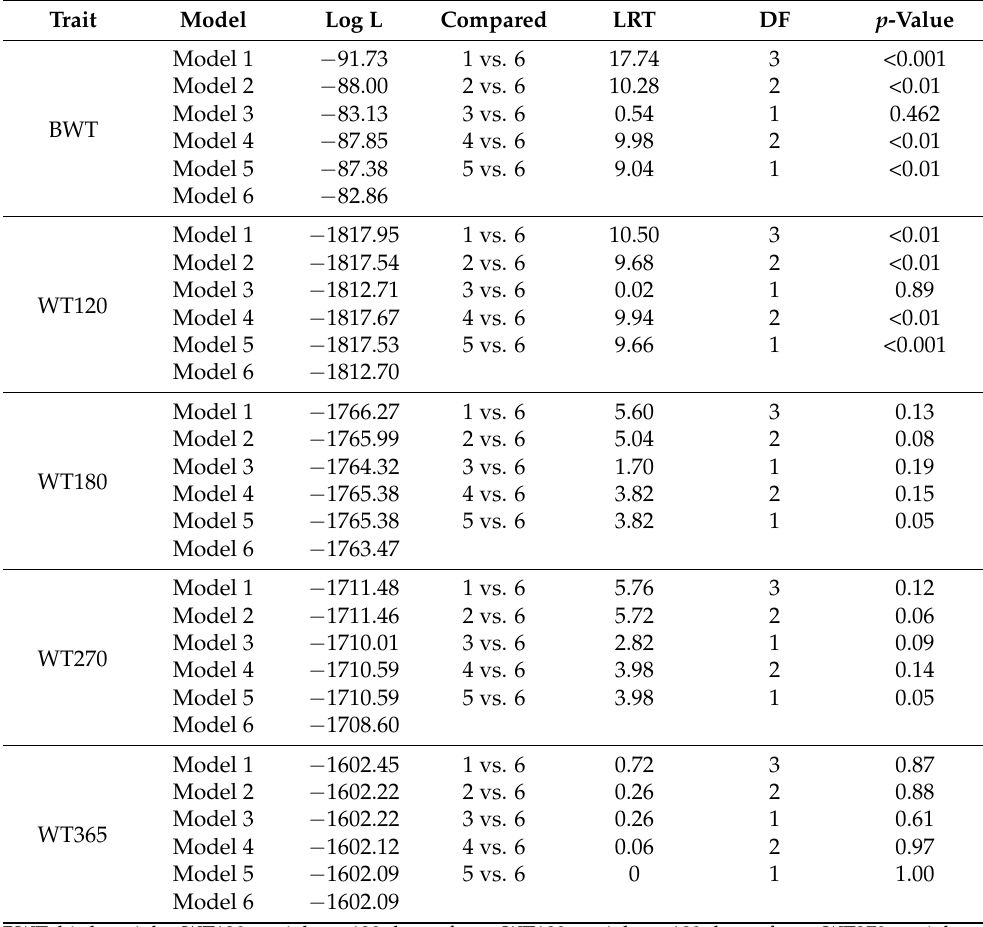
Table 4. Model comparison based on log-likelihood ratios test for growth traits of Lohi sheep. Trait